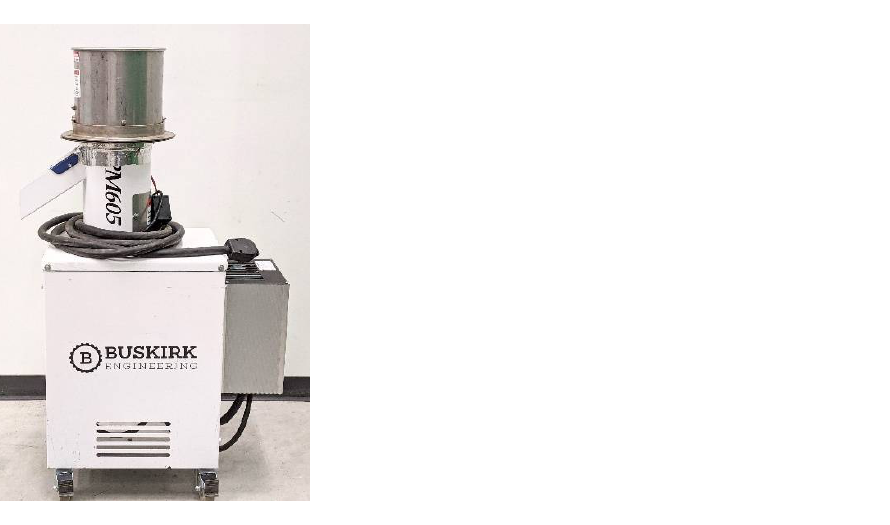
Figure 4. The PM605 (Buskirk Engineering) laboratory-scale pellet mill used to produce lignin